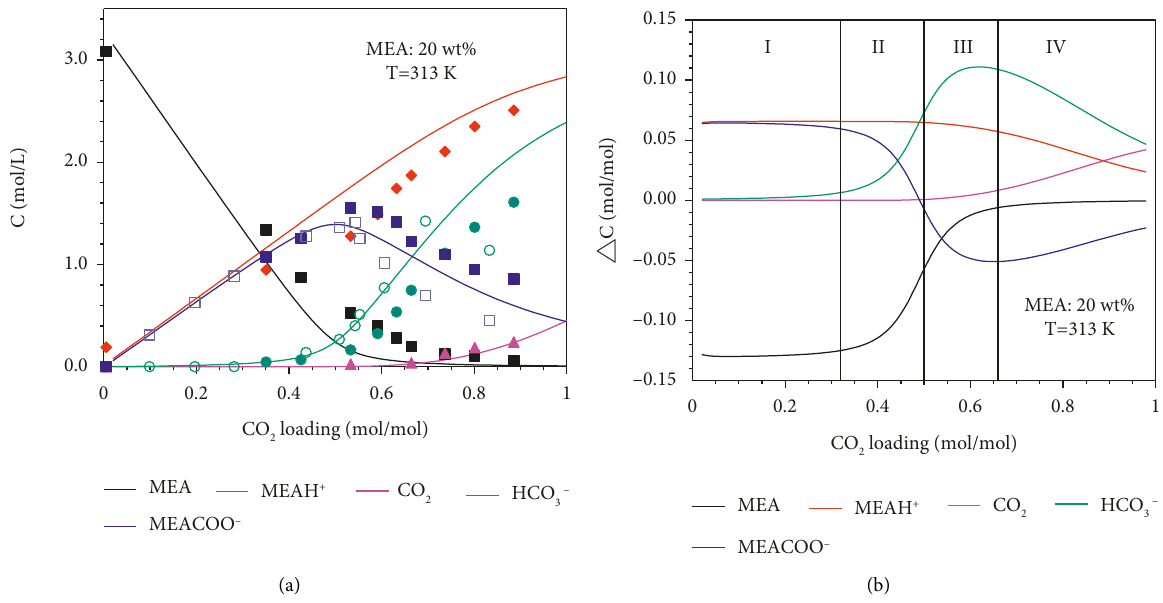
Figure 5: (a) Equilibrium speciation in MEA aqueous solution as a function of CO 2 loading. (b) First-order difference curve of equilibrium speciation as a function of CO 2 loading. Lines: data from modified Kent-Eisenberg model prediction; full symbols: experimental data of Wong et al. [25]; and empty symbols: experimental data of Bottinger et al. [24]. Table 4: Four regions of CO 2 absorption in MEA with CO 2 loading from 0 to 1 at 313K.